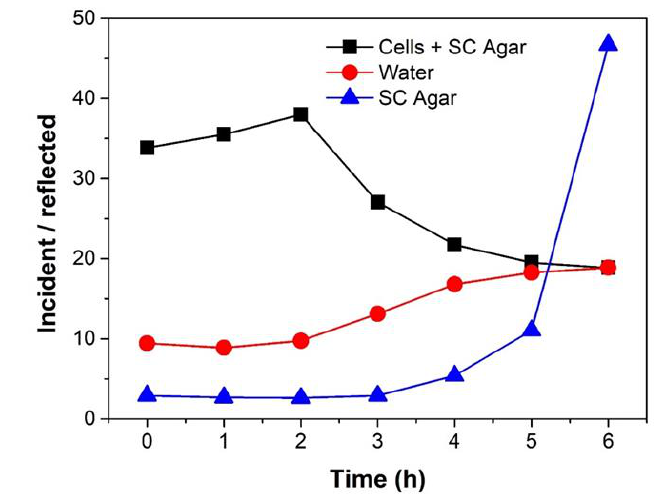
Figure 3. Absorbed power represented as a ratio of incident and reflected power from yeast cells spotted on Synthetic Complete (SC) agar compared to that of plain water and Synthetic Complete (SC) agar without cells respectively. Experiments were performed on a 1 μL spot of 50 cells/μL concentration with a frequency of 85 GHz at an amplitude of 5 dBm over 5 h (corresponding to 1.39 ± 0.02 mW/cm 2 surface power density) .